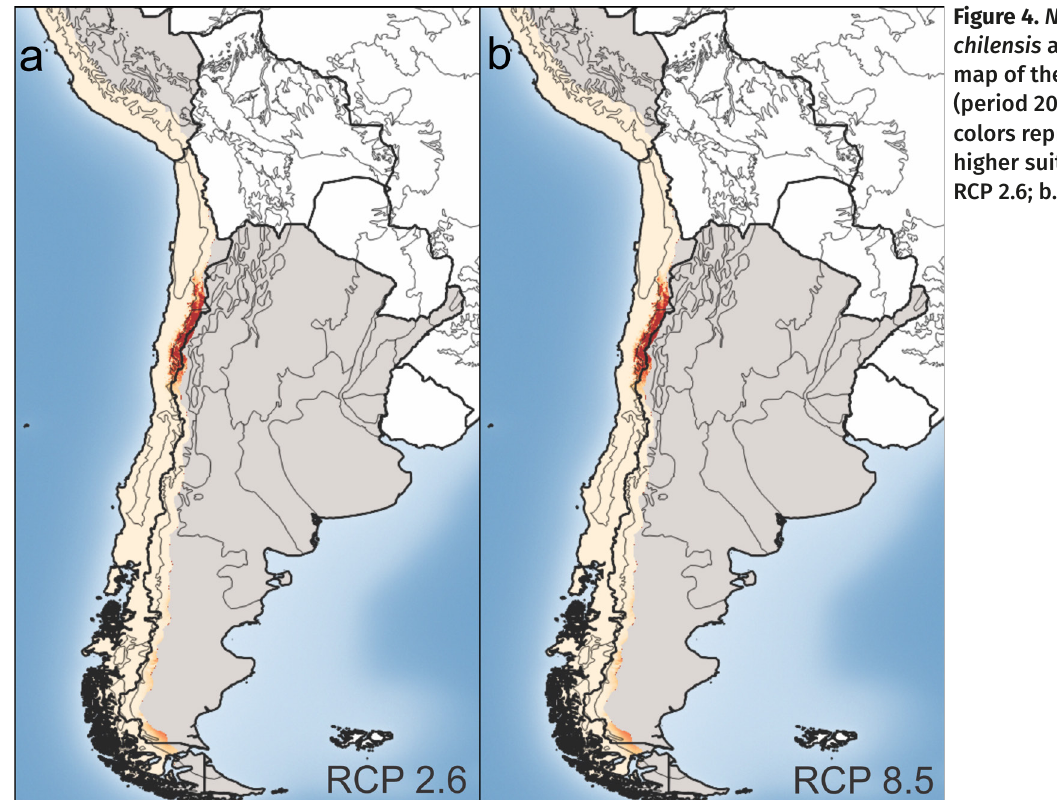
Figure 4. Neta chilensis average map of the three GCM (period 2050), darker colors represent higher suitability. a. RCP 2.6; b. RCP